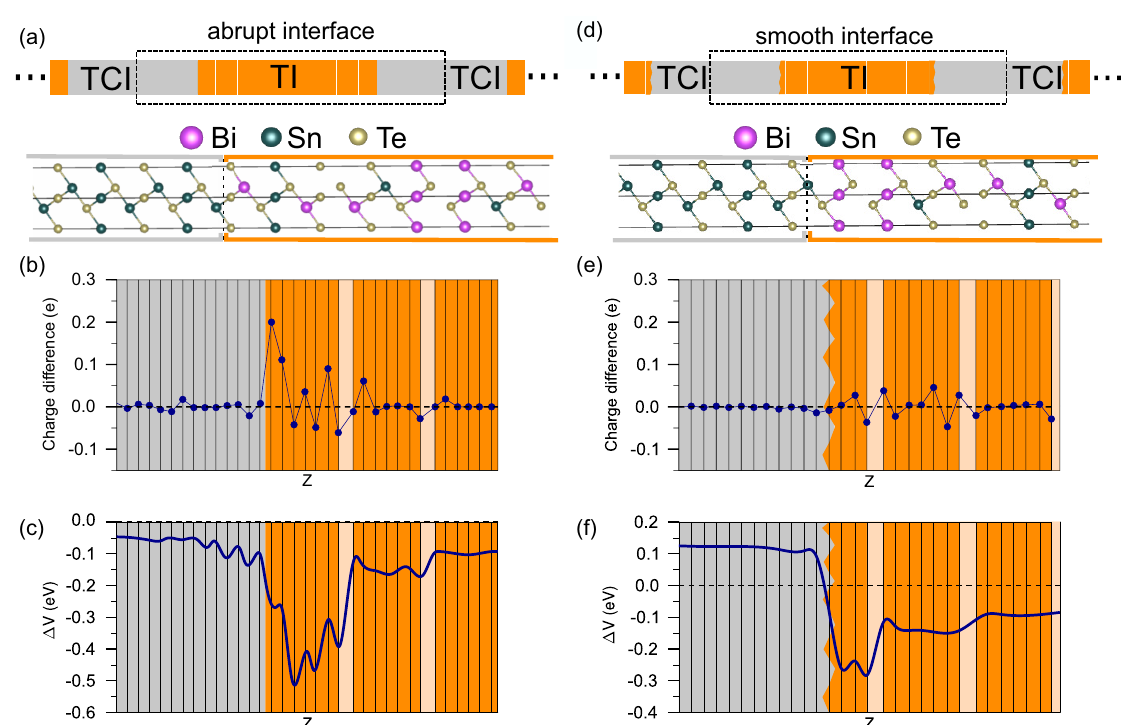
Figure 2. Schematic view ( top ) and atomic geometry ( bottom ) of the supercell containing abrupt TI/TCI interfaces ( a ). Vertical dashed line in bottom part of panel ( a ) shows a border between two materials SnTe and SnBi 2 Te 4 . Atomic charge difference with respect to the electronic charge in center of the SnBi 2 Te 4 (orange) and SnTe (grey) slabs, respectively ( b ). Change of the total electrostatic potential averaged over xy planes with respect to that in the bulk of the SnBi 2 Te 4 (orange) and SnTe (grey) slabs ( c ) for abrupt interface. Vertical black lines in the panels ( b , c ) mark the position of atomic layers and light orange regions show van der Waals spacing in SnBi 2 Te 4 . ( d–f ) is the same as ( a – c ) except for a smooth